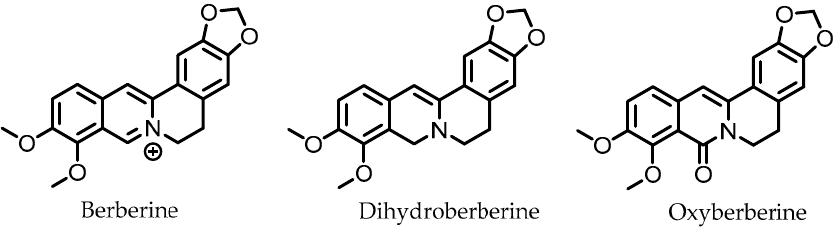
Figure 8. Structures of berberine and its gut microbial metabolites dihydroberberine and oxyber- berine.